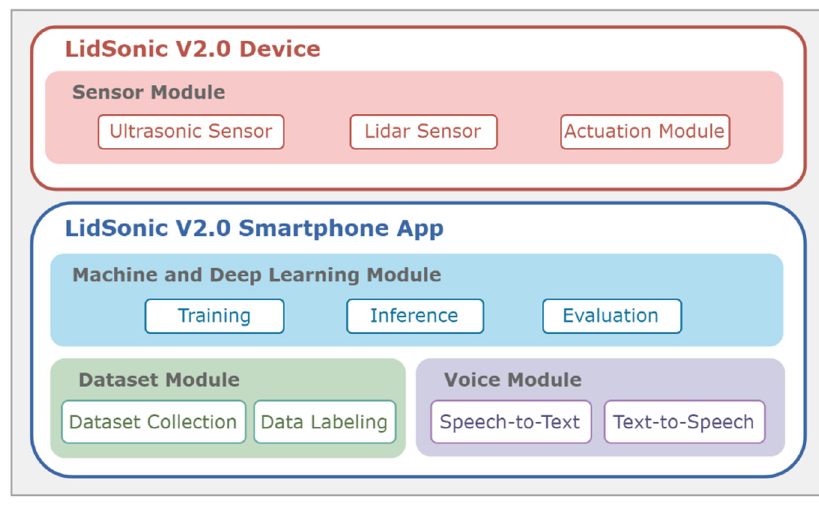
Figure 8. LidSonic V2.0 Software Modules.